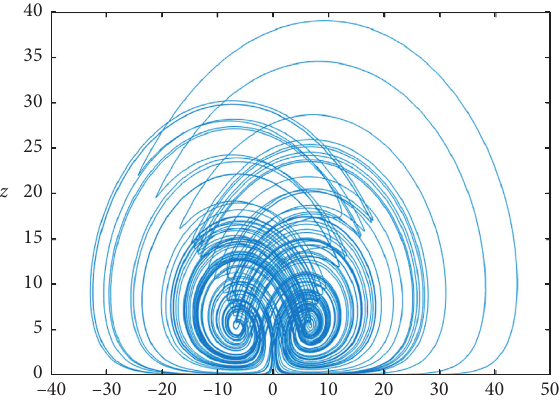
Figure 7: Dynamics of Lu et al.’s fractional-order system with the order α � 0 . 95, in context of x and z directions.